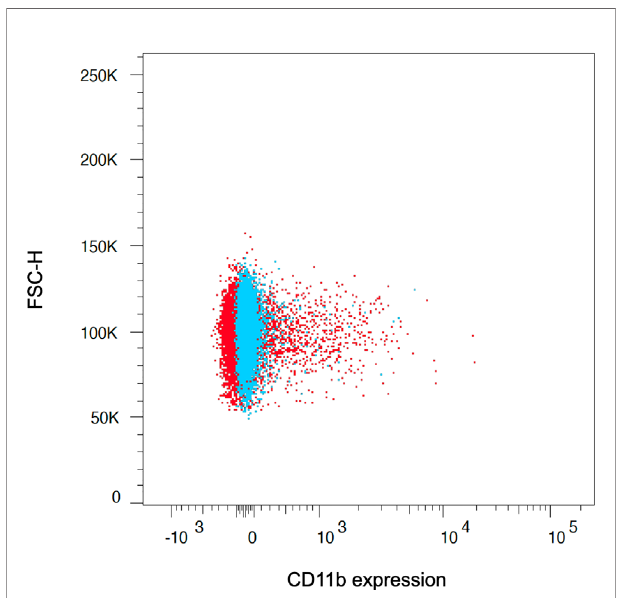
FIGURE 6 | The application of ready-to-use lysis solutions, which combine red cell lysis and cell fi xation at the same time, led to unpuri fi ed and more activated monocyte subsets due to further stimulation of the cells (red population). Therefore, separation of cell fi xation and red cell lysis is crucial to assess the reagent-dependent upregulation of integrins and cytokines, which we achieved with the presented lysis buffer and protocol (blue population). The graph depicts the CD11b expression on CD14++ classical monocytes after red cell lysis and fi xation using ready-to-use lysis solution (red population) and facilitating the presented approach (blue